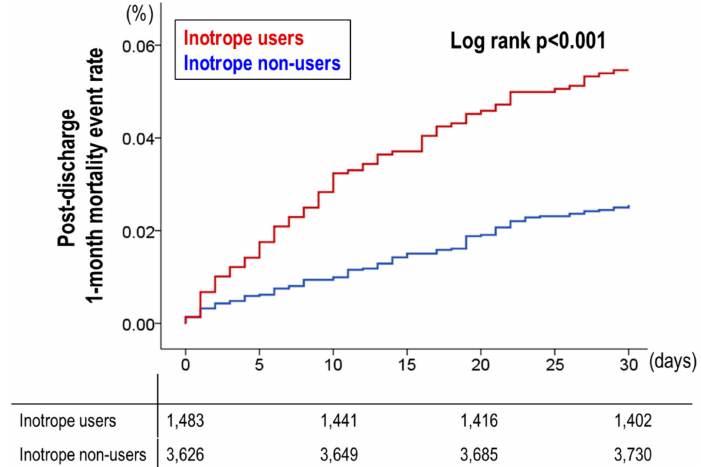
Figure 2. Post-discharge 1-month mortality events by inotrope use. The post-discharge 1-month survival curve showed that the post-discharge 1-month mortality was significantly different between inotrope users and non-users.